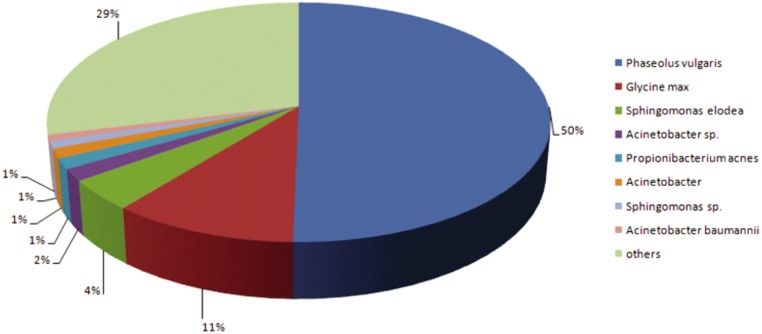
Blast hit distribution of black gram TCS showing similarity with known proteins in non-redundant (nr) database available at NCBI using BLASTx algorithm with an E value threshold of 10–5.